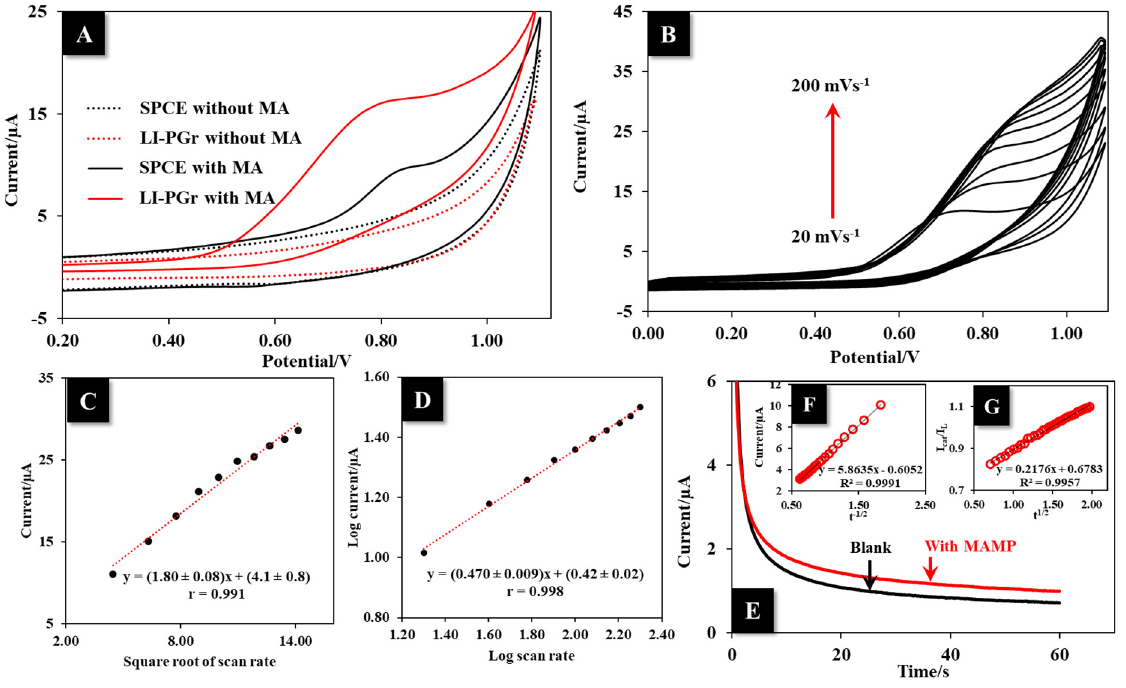
Figure 5. ( A ) CVs were obtained from an SPCE (black line) and the LI-PGr (red line) in BR buffer of pH 10.00 with (solid line) and without (dot line) 10 µg mL − 1 MA. ( B ) CV responses at different scan rates (20–200 mV s − 1 ) were produced at the LI-PGr electrode in the presence of 10.0 µg mL − 1 MA. ( C ) The plot is of the square root of the scan rate ( ν 1/2 ) vs. the peak current (I). ( D ) The plot of log ν vs. log I. ( E ) i–t curves of LI-PGr electrode with and without 10.0 µg mL − 1 MA at 0.70 V. ( F ) The plot of I vs. t − 1/2 and ( G ) the plot of I cat /I L vs. t 1/2 .